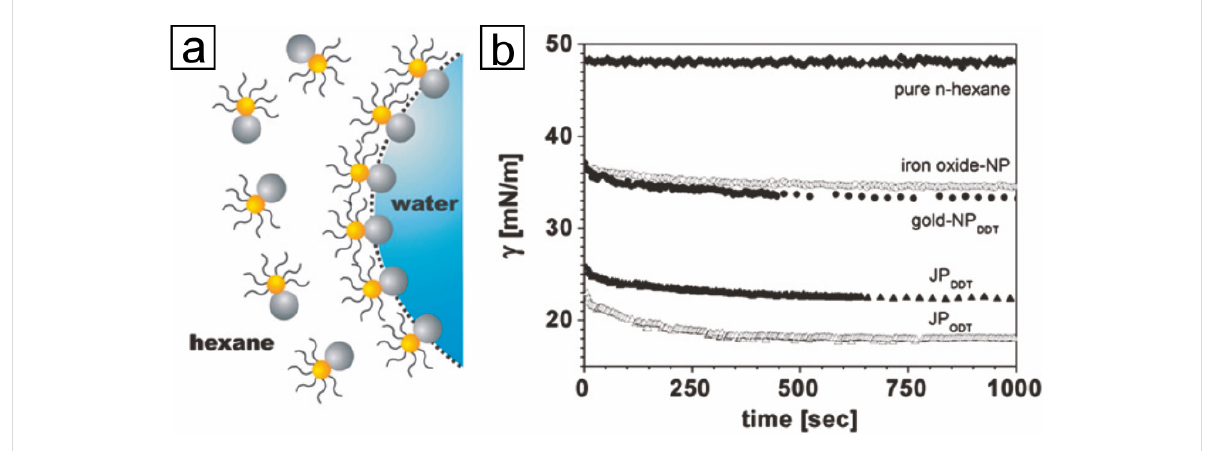
Figure 4: (a) Schematic representation of bimetallic Janus particles at the hexane–water interface (gold: gold part with surfactant; gray: iron oxide part). (b) Interfacial tension vs time as measured by pendant drop tensiometry (NP: homogeneous nanoparticles; JP: Janus particles). The gold domains were functionalized using 1-dodecanethiol (DDT) or 1-octadecanethiol (ODT). Adapted with permission from [32]. Copyright 2006 American Chemical